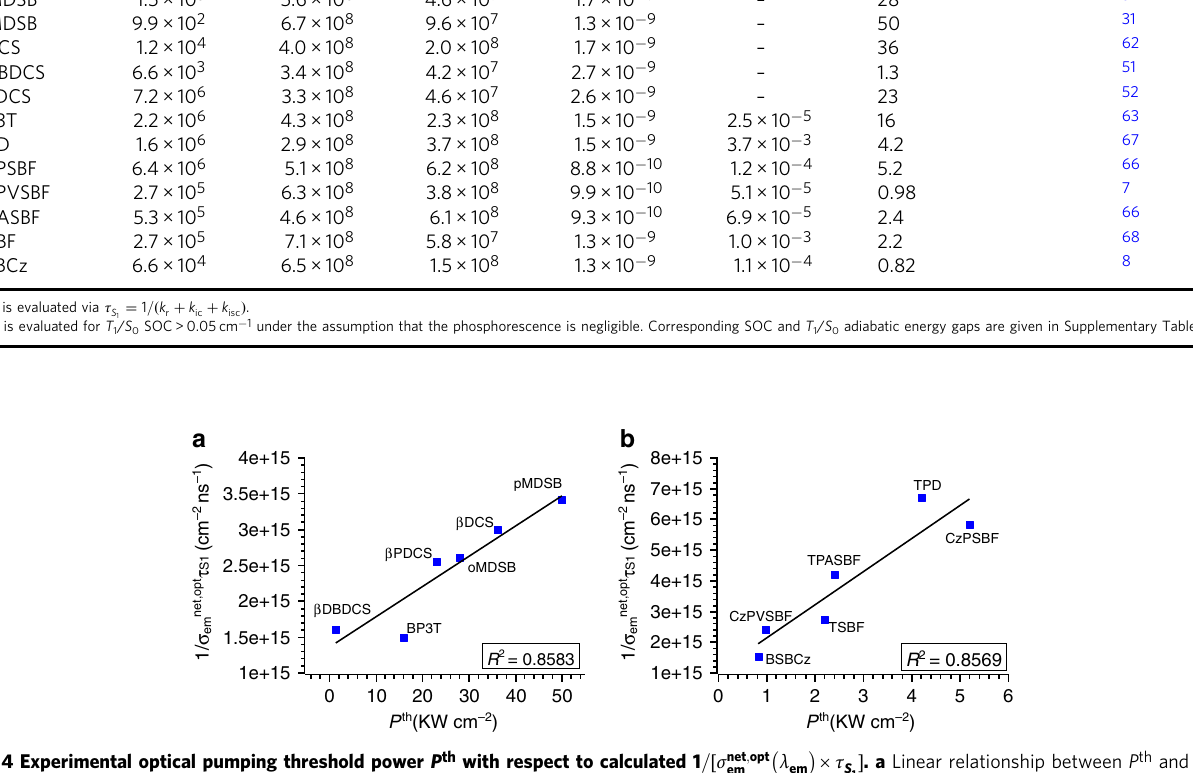
Fig. 4 Experimental optical pumping threshold power P th with respect to calculated 1 = ½ σ net ; opt (cid:2) (cid:3) λ (cid:3) for single-crystal materials, and b the same linear relationship for thin fi lm materials. The linear fi tting coef fi cient R 2 is ~0.85 for both ´ τ 1 = ½ σ net ; opt S 1 em em groups, indicating a good linear relationship and thus veri fi es our computational